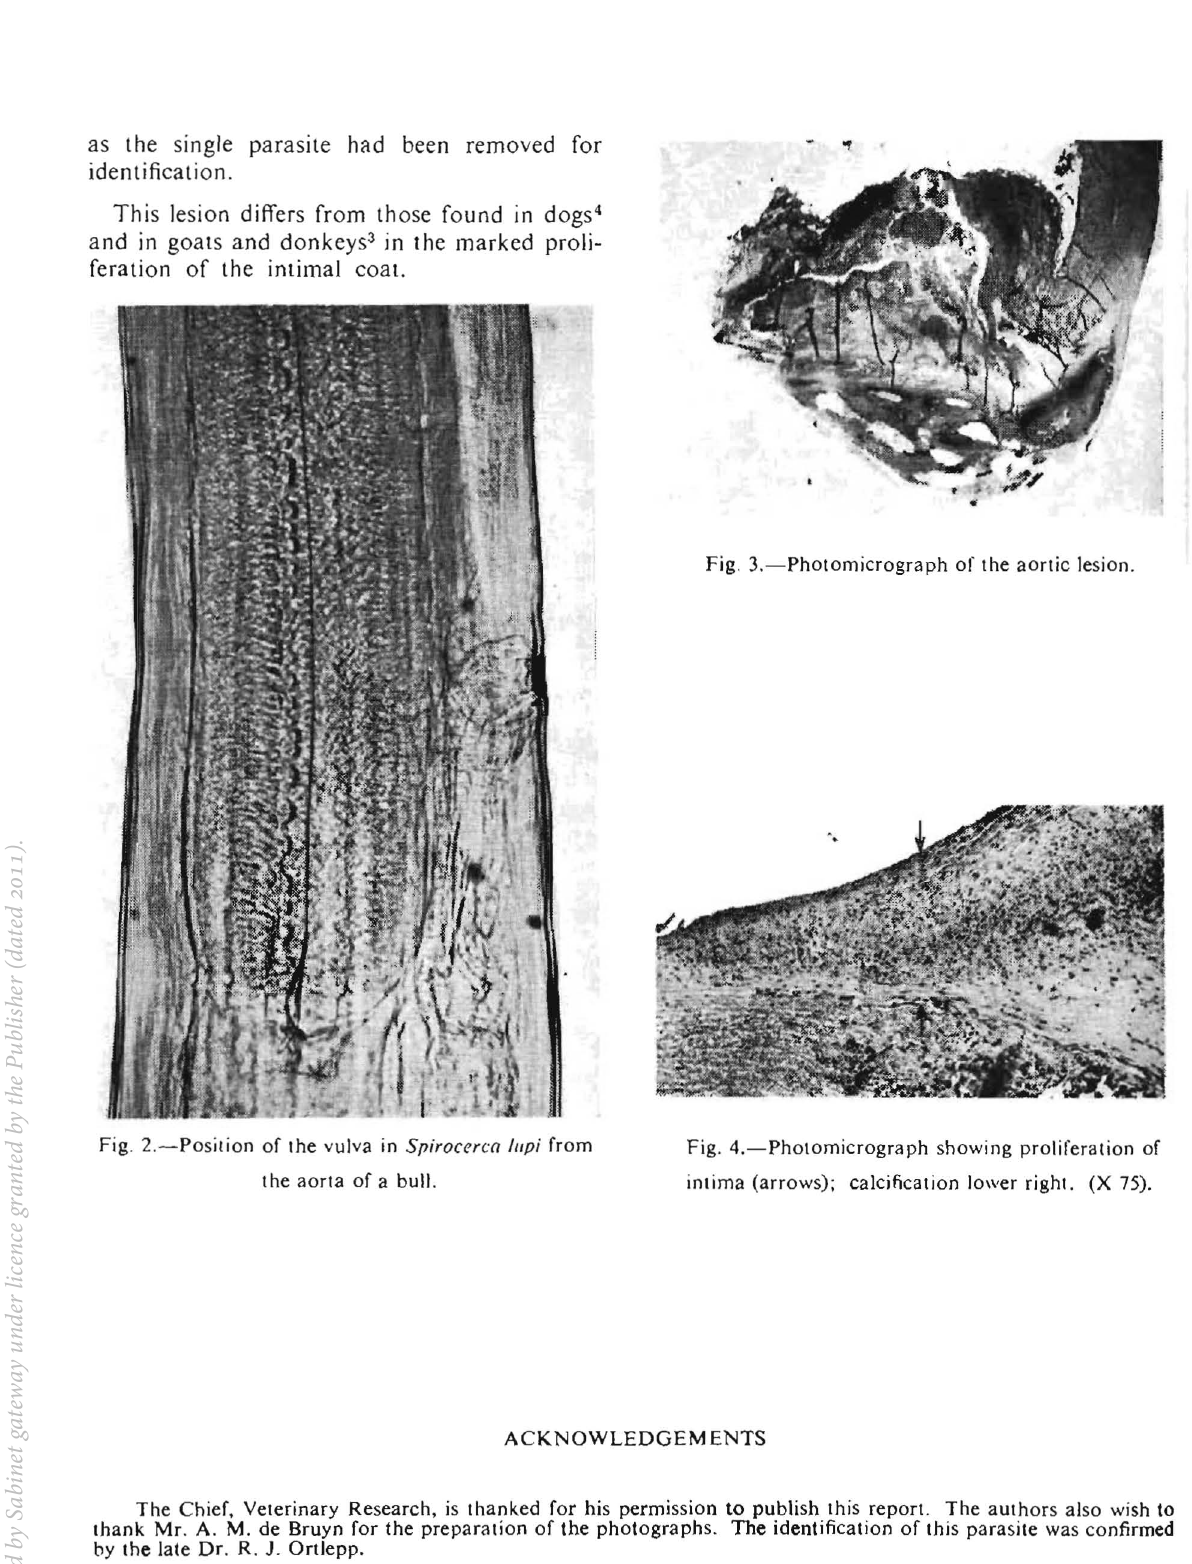
Fig. 4.-Photomicrograph showing proliferation of intima (arrows); calcification lower right. (X